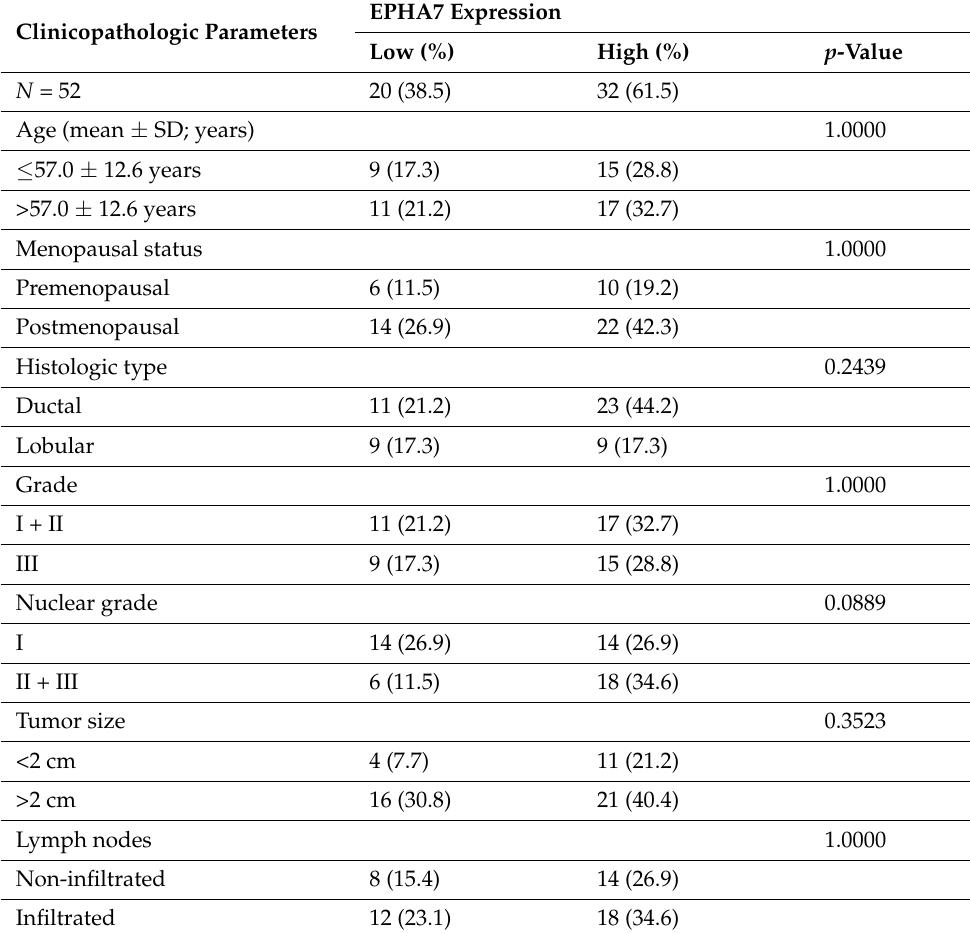
Table 3. Association of EPHA7 expression with selected clinicopathologic parameters in 52 triple- negative breast cancer (TNBC) patients ( p -values calculated through the Fisher’s exact